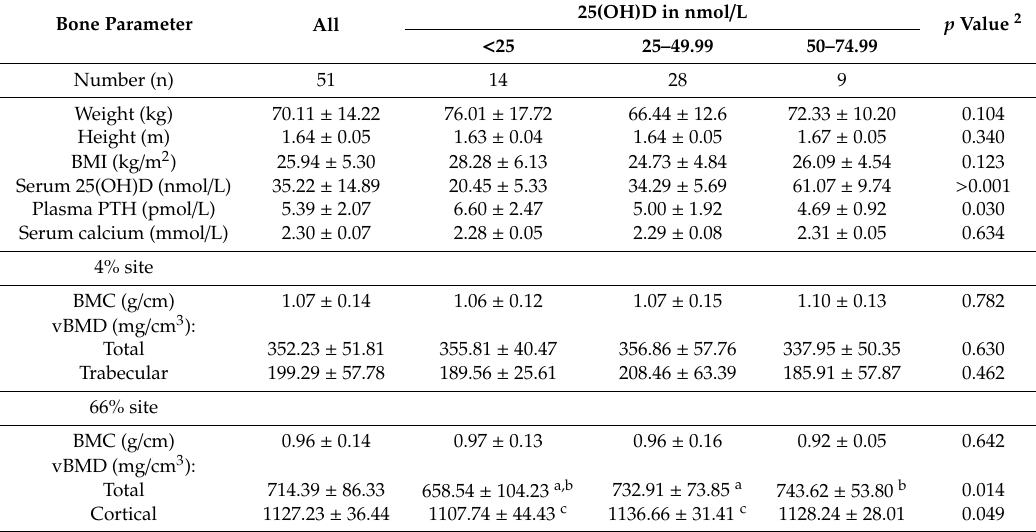
Table 6. Radial bone densitometry assessed by pQCT of Brazilian women living in England by vitamin D status ( n = 51) 1